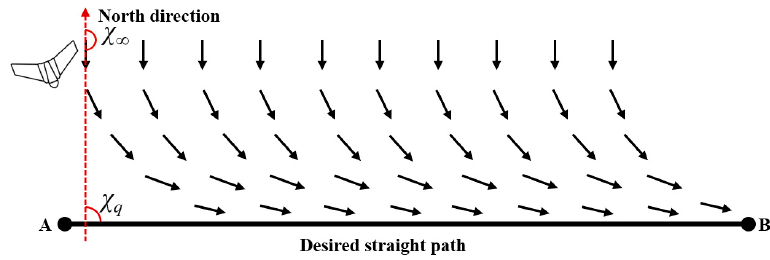
Figure 24. Vector field of the straight path.